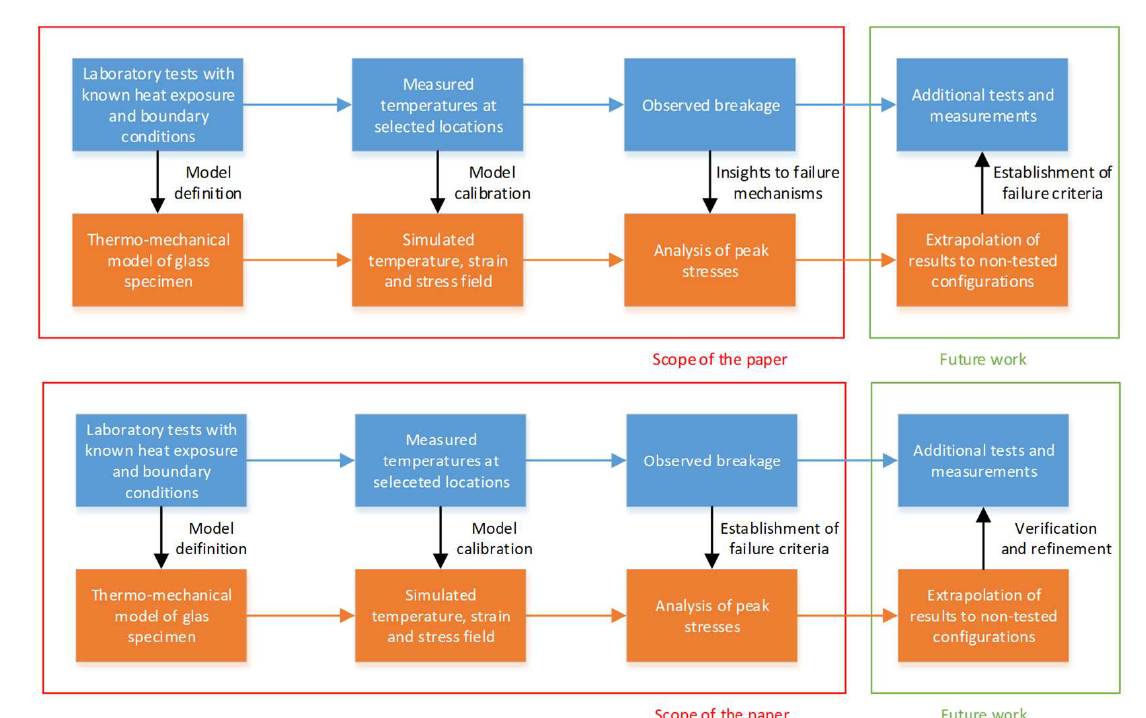
Figure 2. Scope and limitations of the study.